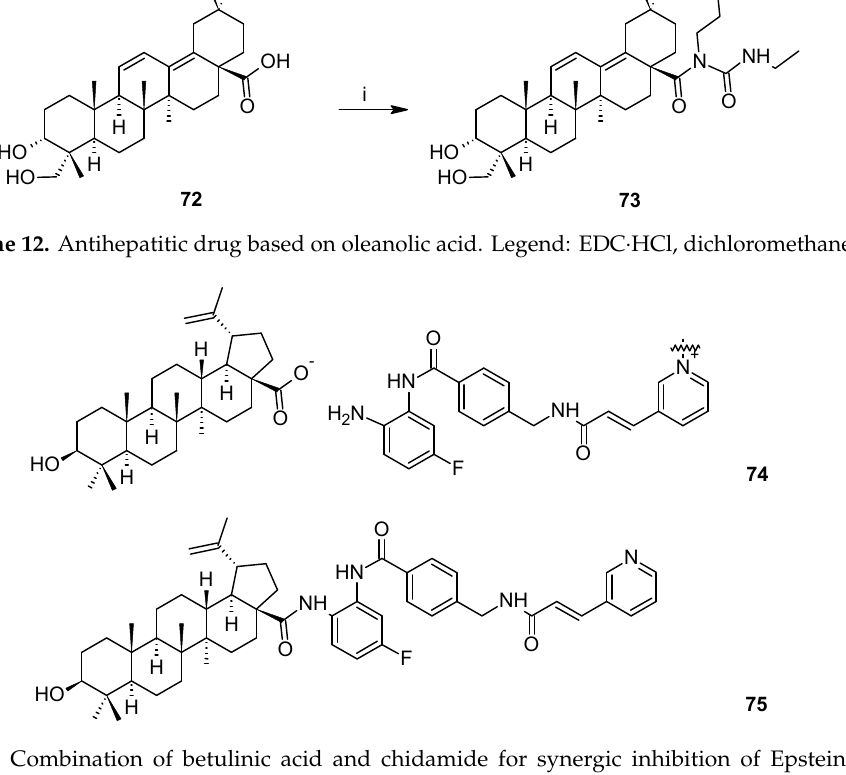
Figure 4. Combination of betulinic acid and chidamide for synergic inhibition of Epstein-Barr virus replication.